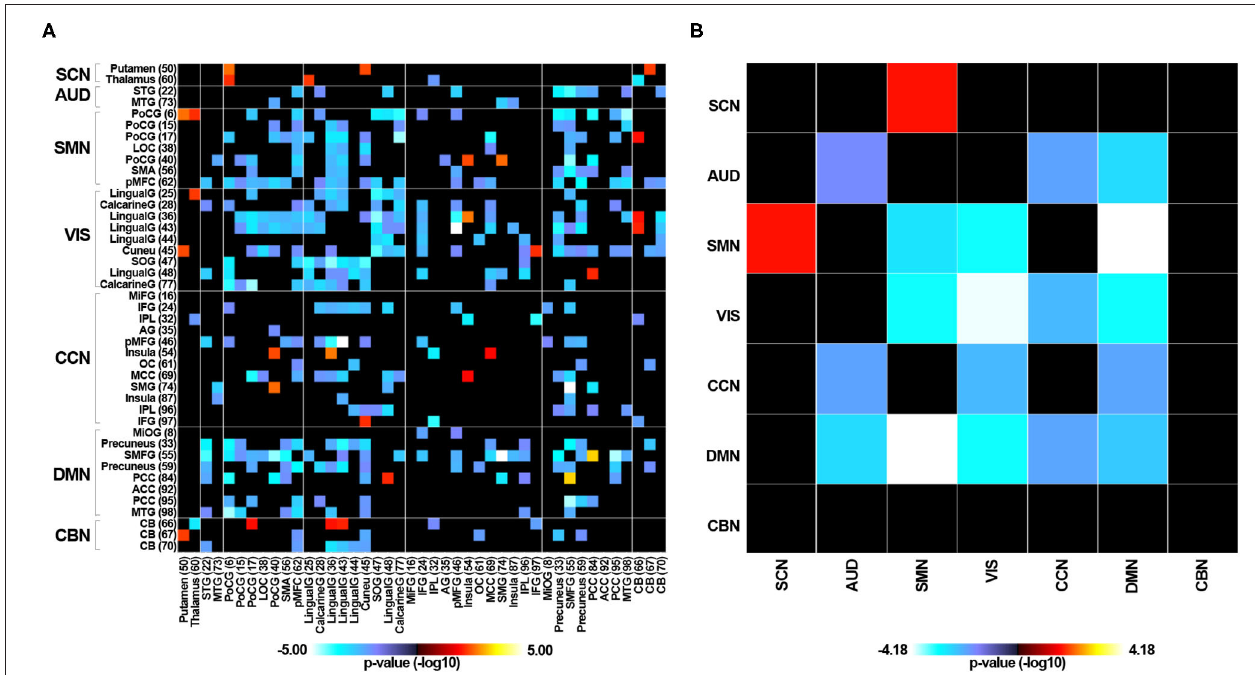
FIGURE 3 | The group comparisons of static functional connectivity. (A) Group difference of static connectivity of 43 independent components between the RTLE and HC groups ( P < 0.05, FDR corrected). (B) Group difference of static connectivity of seven functional networks between the RTLE and HC groups ( P < 0.05, FDR